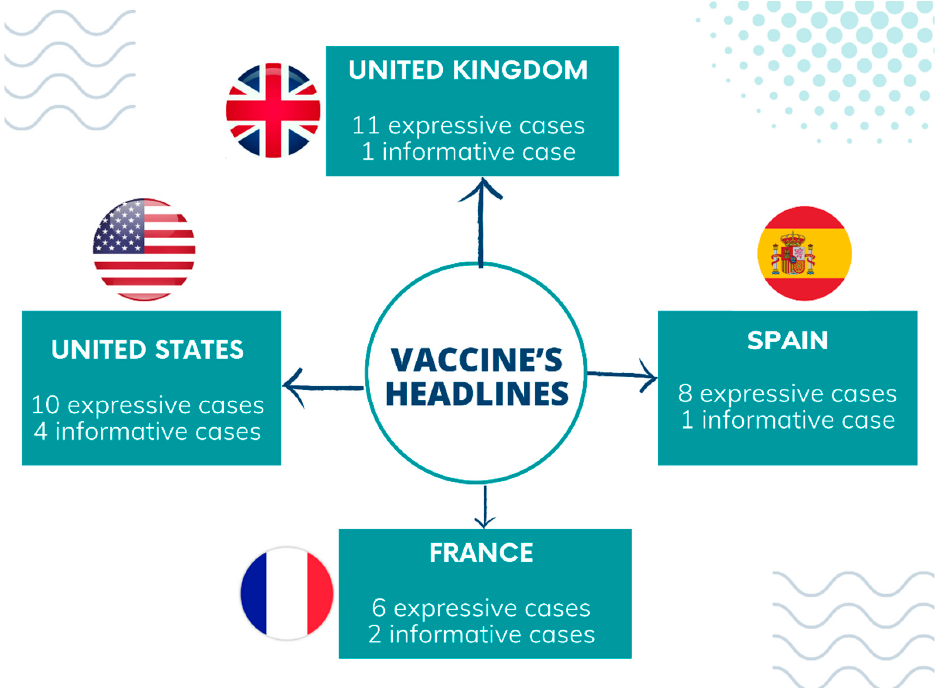
Figure 7. Analysis of vaccine headlines.